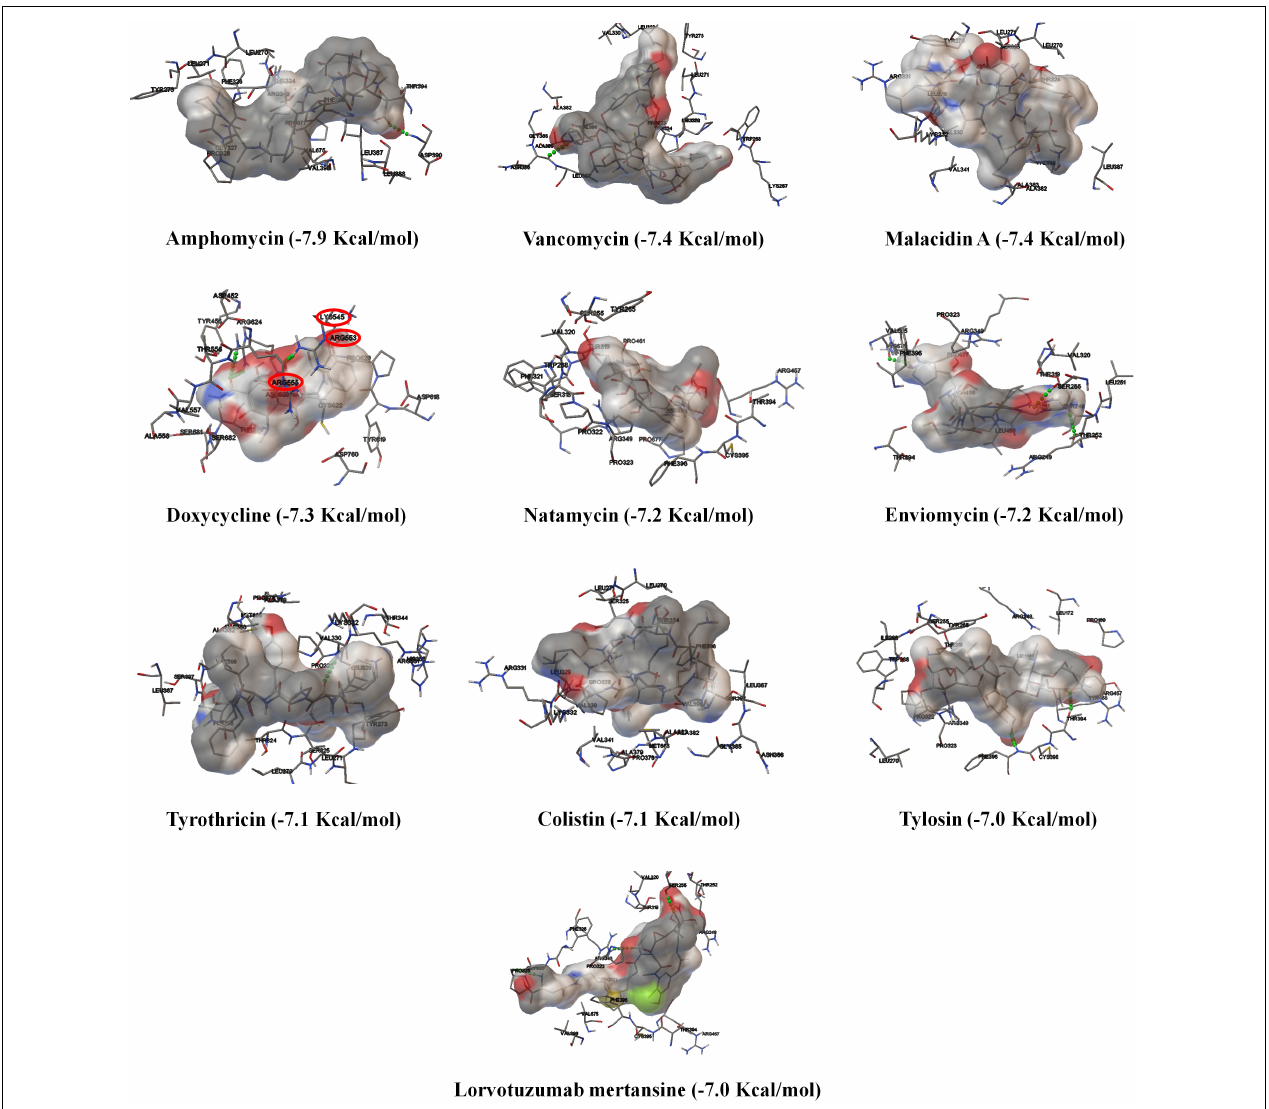
FIGURE 3 | Schematic representation of mode of action of doxycycline against SARS-CoV-2. The binding patterns and aminoacid interactions of the best scoring antibacterial drugs with SARS-CoV-2 RdRp. The red circle-marking indicates the interaction with the active site (NTP binding channel) of SARS-CoV-2